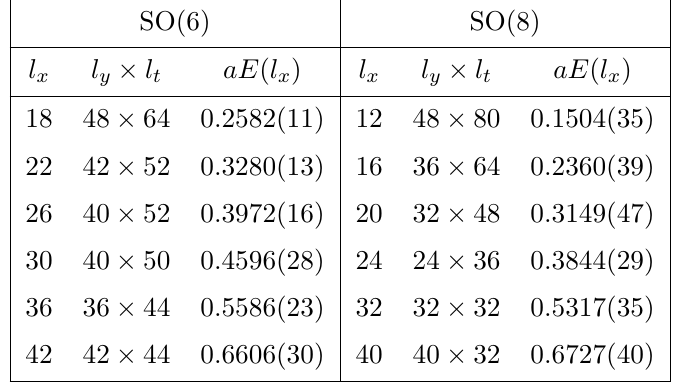
Table 6 . Energy of the ground state (cid:13)ux tube versus its length, in SO(6) at (cid:12) = 46, and in SO(8) at (cid:12) = 86.